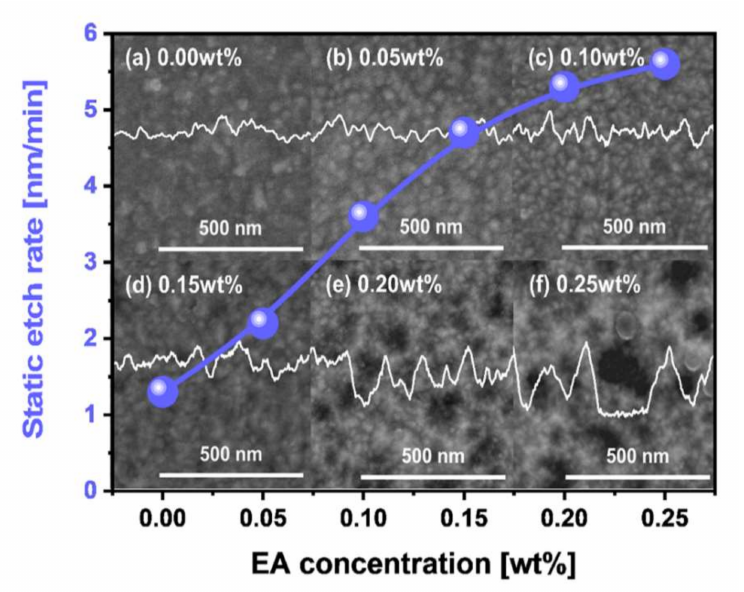
Figure 4. Corrosion magnitude (i.e., static etch rate) and corrosion-induced surface morphology depending on the scavenger (i.e., EA) concentration. ( a ) EA of 0.00 wt%; ( b ) EA of 0.05 wt%; ( c ) EA of 0.10 wt%; ( d ) EA of 0.15 wt%; ( e ) EA of 0.20 wt%; ( f ) EA of 0.25 wt%. Background SEM images show the presence and magnitude of corrosion on the W-film surface after dipping the W-film into the CMP slurry with a scavenger (i.e., EA). The lateral profiles of image contrast on the SEM images correspond to the magnitude of